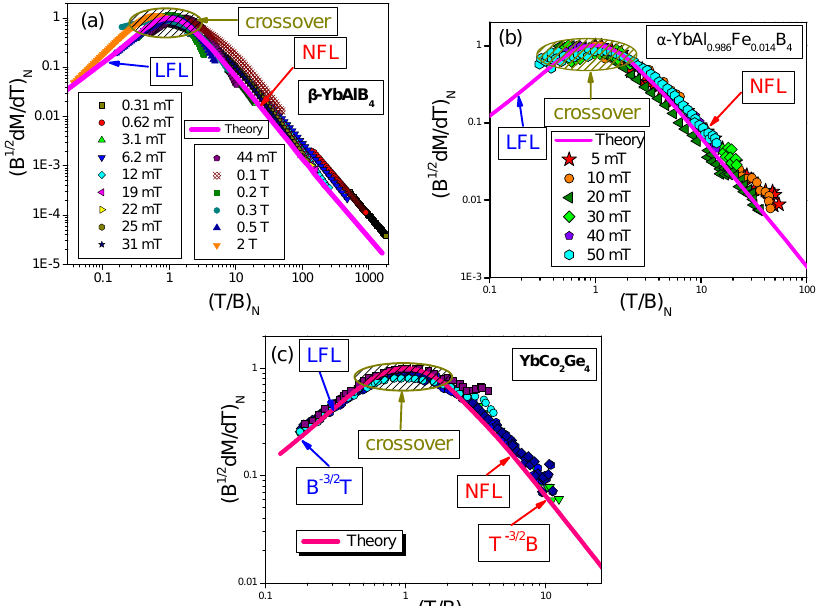
Figure 16. Scaling of dimensionless normalized magnetization ( B 1/2 dM ( T , B ) / dT ) N as a function of the dimensionless normalized ( T / B ) N at magnetic field values B given in the legends ( a , b ). Regions of LFL behavior, crossover, and NFL behavior are indicated by arrows. The theory is represented by the solid curve [14,43]. Data are extracted from [32–34]. Panel ( a ): Scaling of β ( b ): Scaling of α YbAl 1 x Fe x B 4 . Panel ( c ): Scaling of YbCo 2 Ge 4 , measured at different field values − − B = 0.05,0.1,0.2,0.3,0.5 T